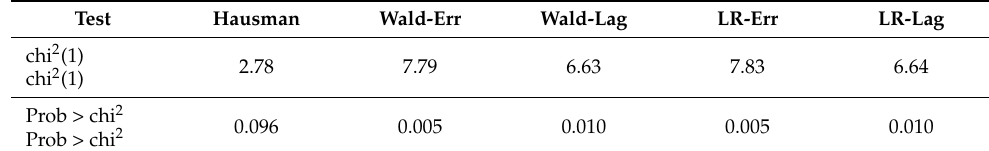
Table 2. Test results of the spatial panel model.